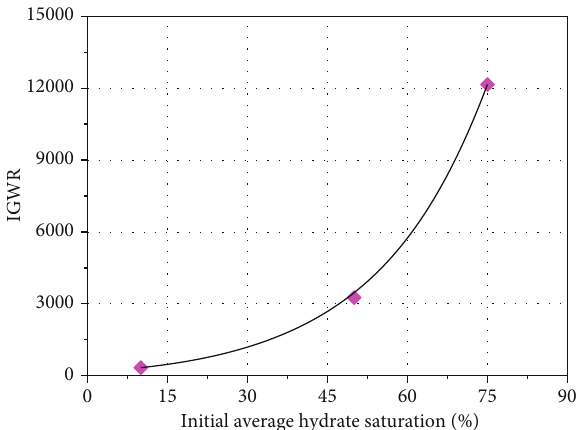
Figure 8: The IGWR increase with the increase in initial hydrate